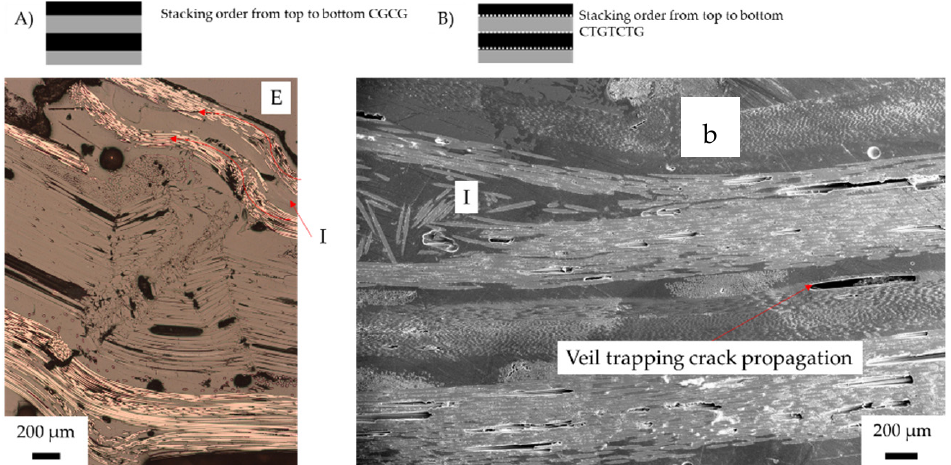
Figure 18. Post-failure micrographs of carbon/glass hybrid fibre samples after three-point bending: ( A ) alternating (CGCG) failure mechanism of toughened structures with carbon fibre under compres- sion; ( B ) CTGTCTG. Annotation: E (elastic buckling), I (inter fibre failure) and b (fibre buckling). Red lines indicate fibre failure, fibre direction shown with red arrow.